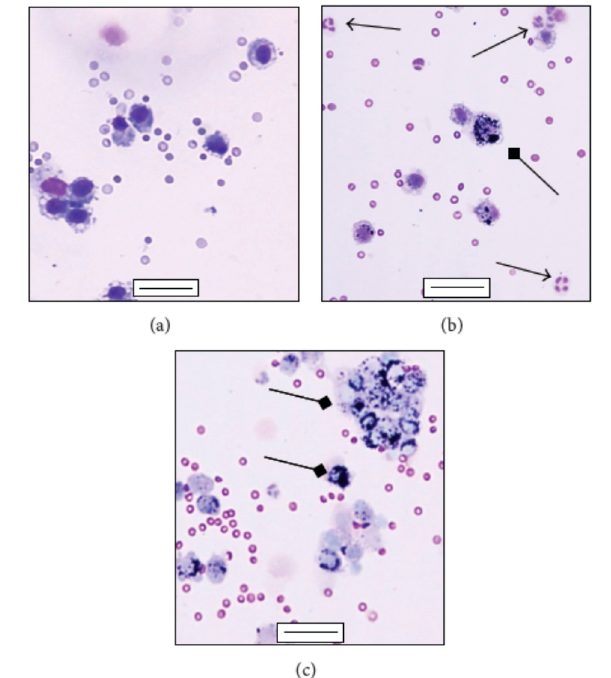
Figure 7. Di ff erential staining of mouse bronchoalveolar lavage fluid (BALf) cells after PM1 intratracheal instillation. ( a ) Alveolar macrophages in the BALf collected 24 h post instillation from sham; ( b ) and ( c ) alveolar macrophages engulfing particles (square arrows) and infiltration of polymorphonuclear leukocytes (PMNs) (arrows) in the BALf collected 24 h after the last intratracheal instillation from PM1-treated mice. ( a – c ) bars = 50 µ m. Reproduced with the permission from [56].